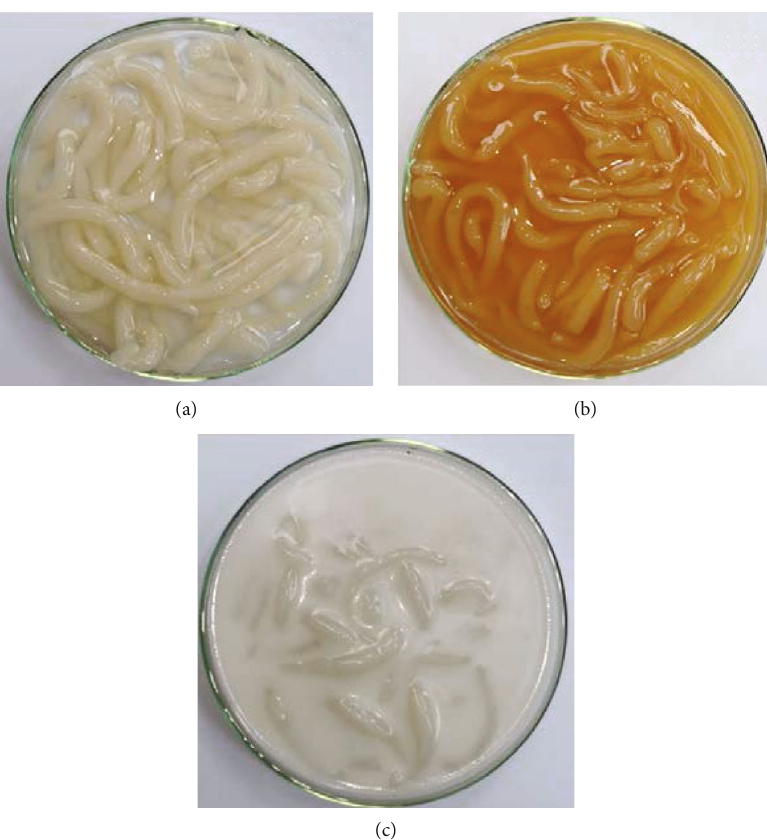
Figure 1: Appearance of the model desserts prepared in water (a), 45 ° Bx sucrose solution (b), and coconut milk